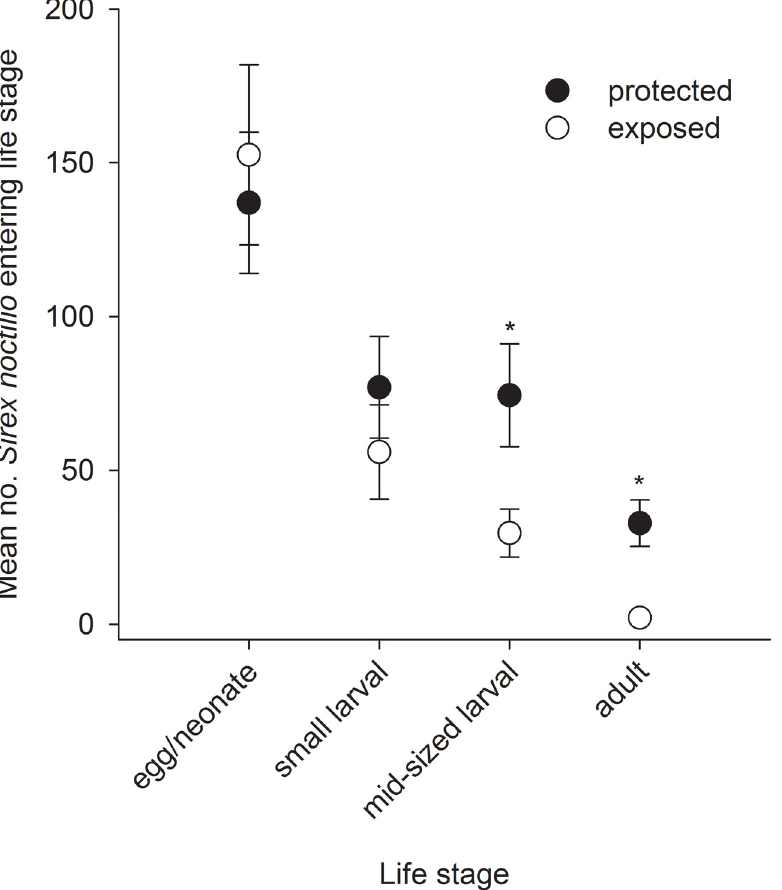
Fig 2. Mean number of Sirex noctilio at the beginning of each life stage in experimentally-manipulated cohorts. For each treatment, dots represent the mean number of S . noctilio recovered from 9 logs (~0.07 m 3 wood) that were collected in October (egg/neonate — mid-sized larval), or from a second set of 9 logs (0.07 m 3 wood) that were collected in June (adult), and error bars represent standard errors. Cohorts were either protected from (filled dots) or exposed to (open dots) the naturally-occurring community of associates. The effect of exposure to associates was tested separately for each life stage. * P < 0.01 according to Tukey ’ s HSD.